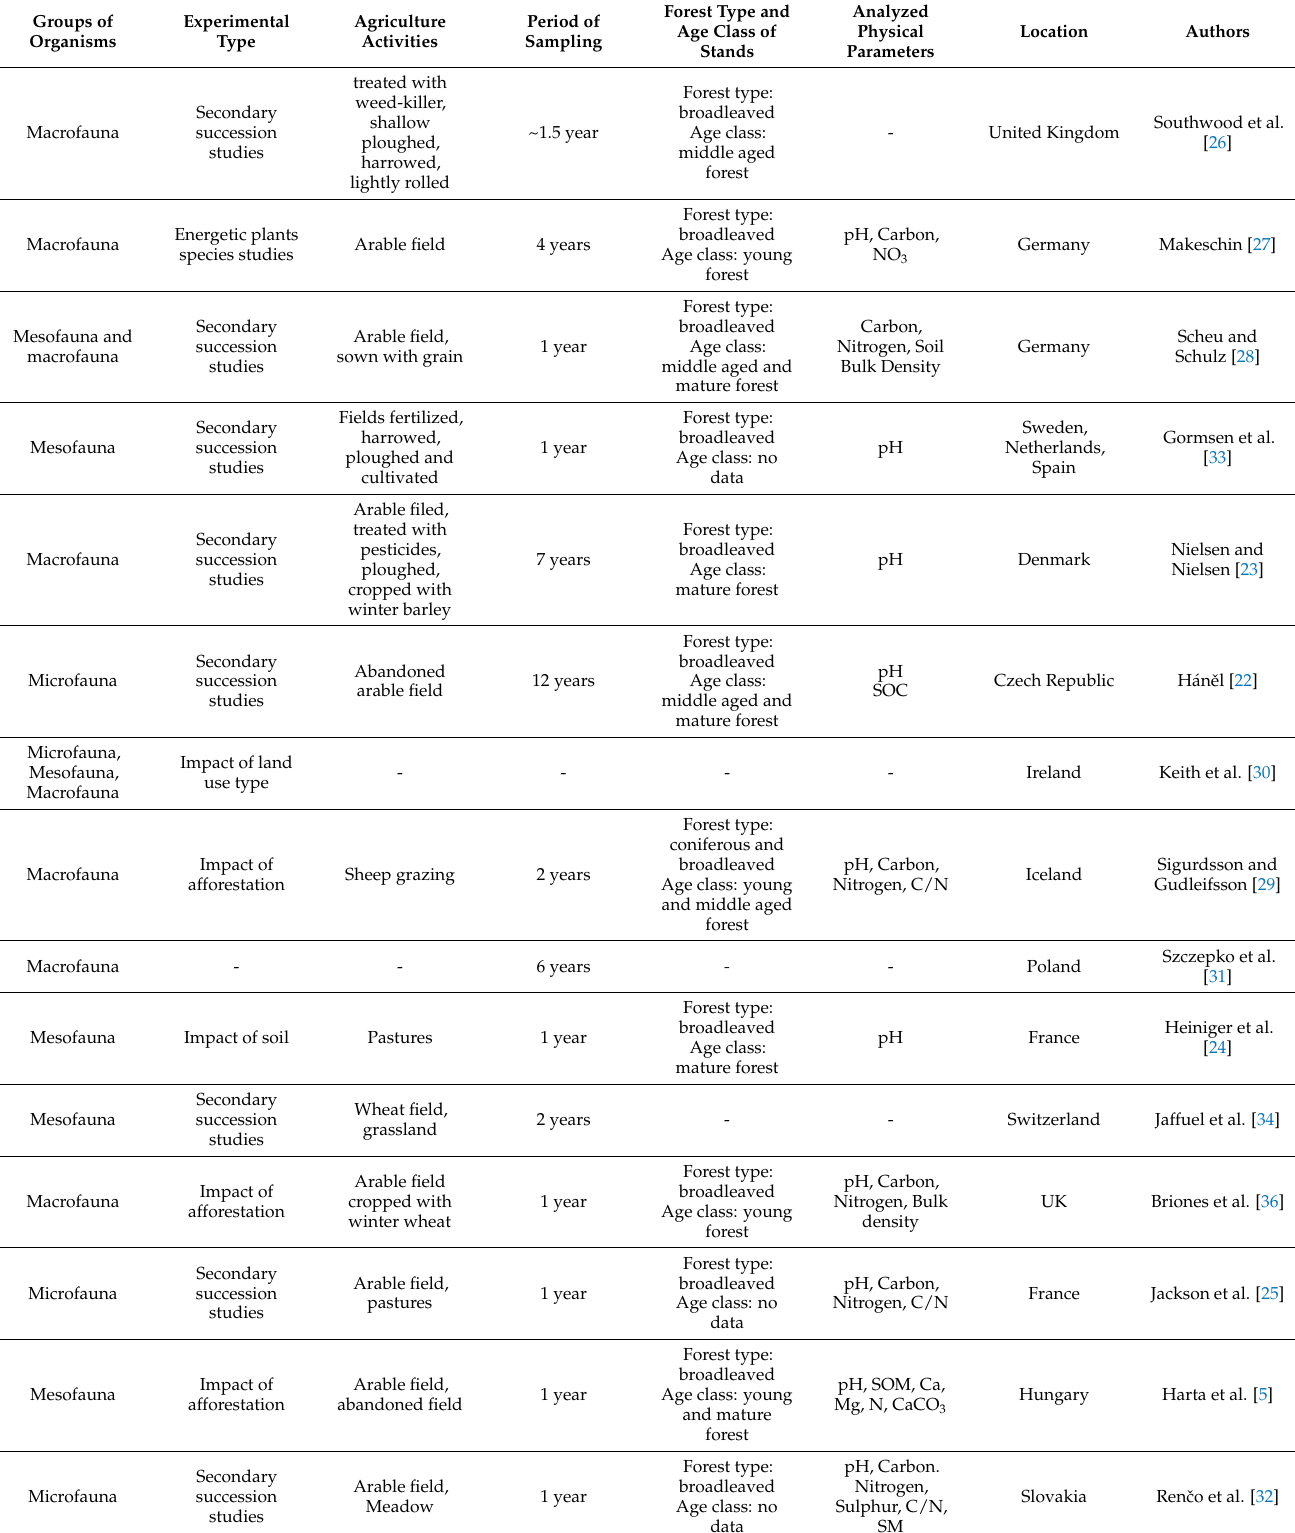
Table 1. Summary of the studies investigating the communities of soil fauna on post-agricultural lands. Abbreviations indicate: SM—soil moisture, SOM—soil organic matter. Age class of forests were applied as follows: 1–30 young forest, 31–80 middle age forest, 81 > mature forest. Summary based on